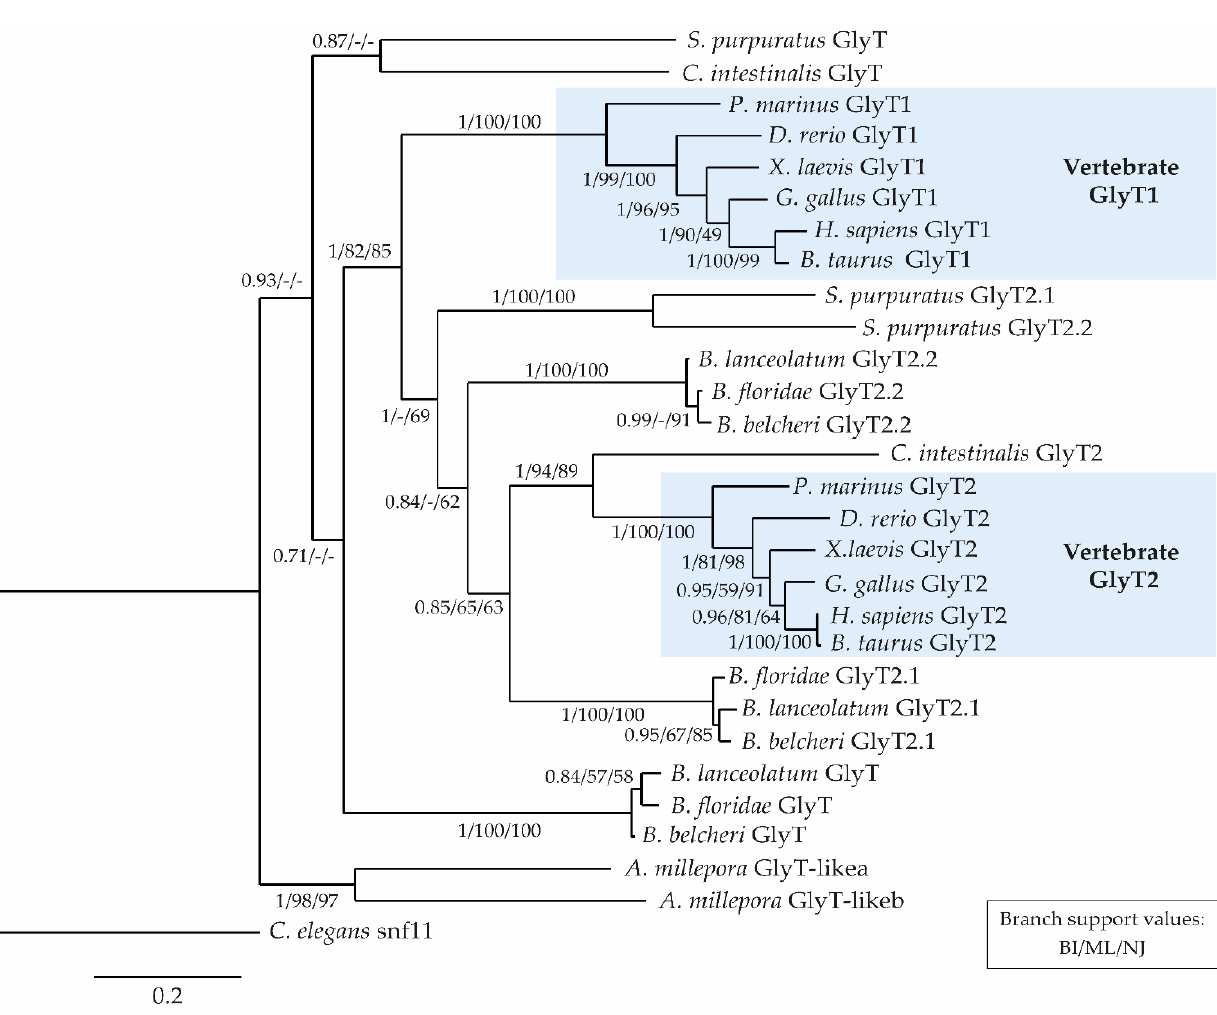
Figure 2. Phylogenetic tree of glycine transporter proteins. Bayesian Inference (BI), Maximum Likelihood (ML), and Neighbor Joining (NJ) methods were used, and the BI tree is shown with branch support values for the BI, ML, and NJ analyses, respectively. “-“ indicates branches not recovered by the corresponding tree reconstruction method. Branch lengths are expressed as amino acid substitutions per site. Caenorhabditis elegans neurotransmitter transporter snf11 was used as the outgroup. List of animal species featured in the tree: Acropora millepora (coral, cnidarian), Bos taurus (cattle, mammal), Branchiostoma belcheri (Chinese amphioxus, cephalochordate), Branchiostoma floridae (Florida amphioxus, cephalochordate), Branchiostoma lanceolatum (European amphioxus, cephalochordate), Caenorhabditis elegans (roundworm, nematode), Ciona intestinalis (sea squirt, tunicate), Danio rerio (zebrafish, teleost fish), Gallus gallus (chicken, bird), Homo sapiens (human, mammal), Petromyzon marinus (sea lamprey, jawless vertebrate), Strongylocentrotus purpuratus (purple sea urchin, echinoderm), Xenopus laevis (African clawed frog, amphibian).